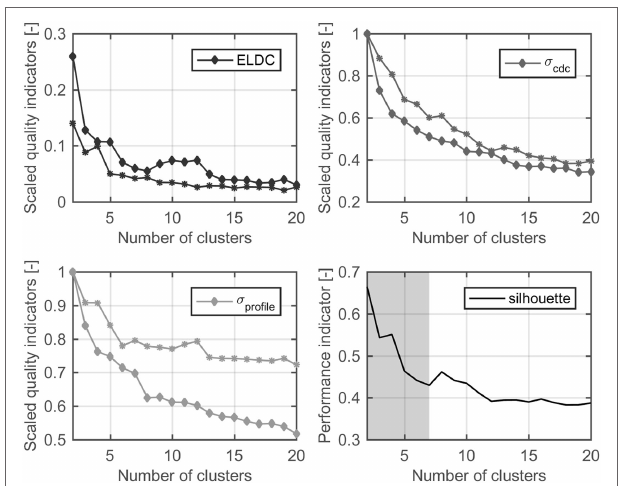
FIGURE 4 | Temporal data reduction quality indicators for global horizontal irradiance (diamond), ambient temperature (star), and performance indicator of Geneva-Cointrin.